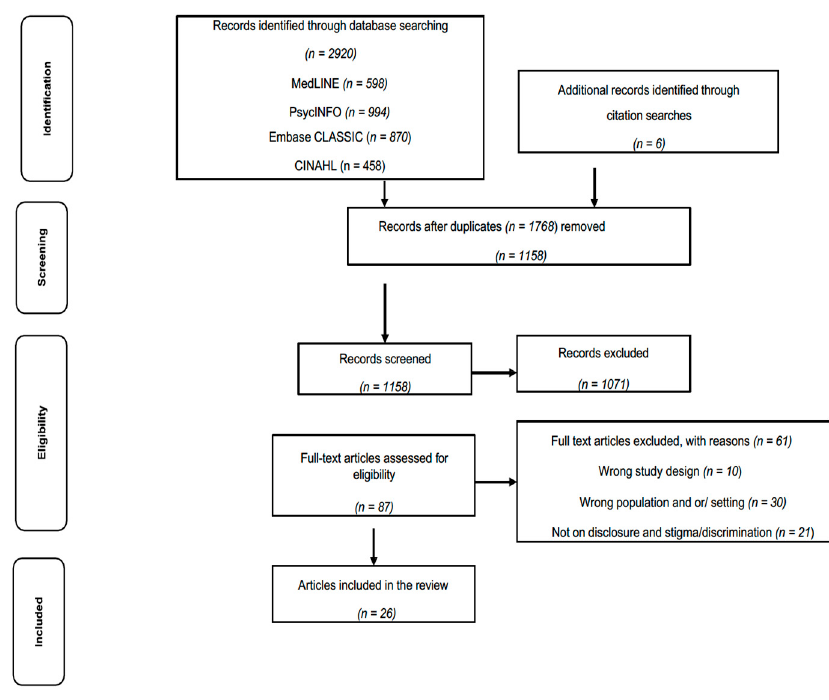
Figure 1. PRISMA Flow Diagram.